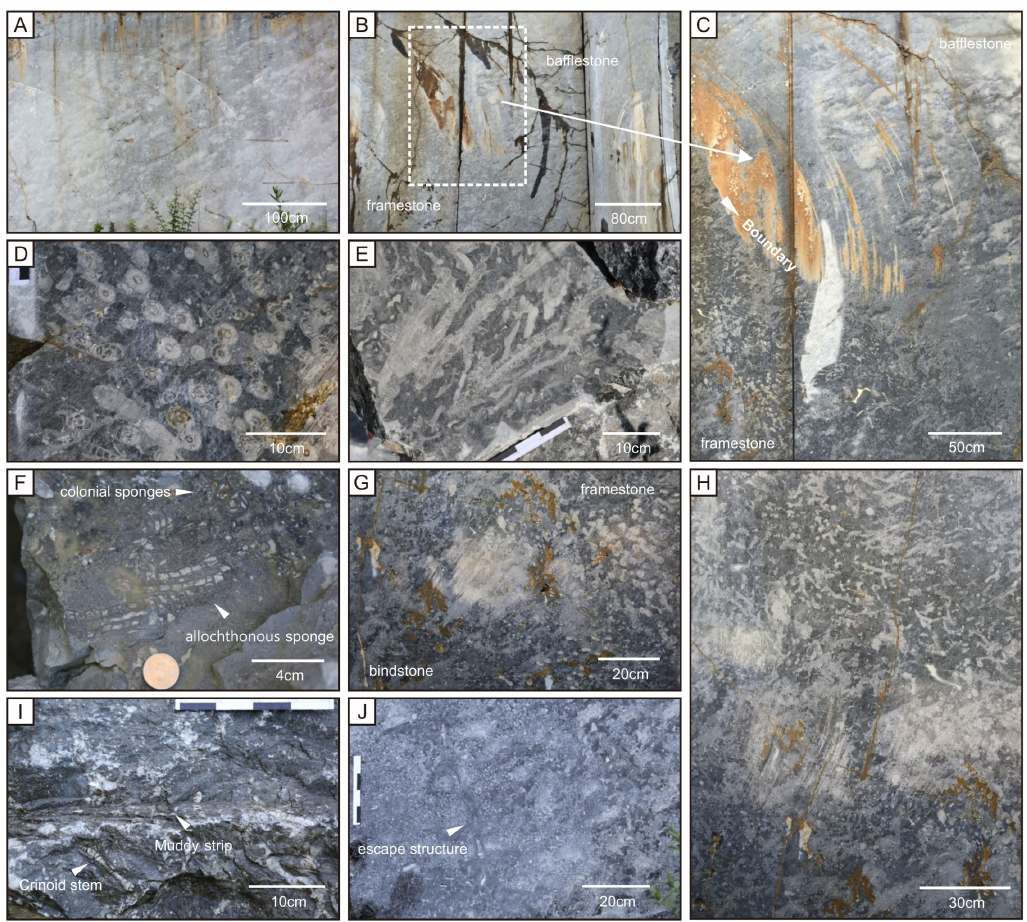
Figure 4. Images of the outcropping lithofacies: ( A ) filled-skeleton sponge bafflestone composed of dark-gray sponges limestone and light-gray bioclastic limestone; ( B , C ) the lateral boundary between the filled-skeleton sponge bafflestone and filled-skeleton sponge framestone; ( D ) cross-section of the filled-skeleton sponge framestone; Sphinctozoan sponge; ( E ) longitudinal section of filled-skeleton sponge framestone; ( F ) allochthonous sponge and in situ sponge colonies; ( G , H ) natural transition between dark gray massive bioclastic limestone and filled-skeleton sponge framestone; ( I ) bioclastic limestone with muddy strips; crinoid stem with lengths of 5–10 cm; ( J ) massive bioclastic